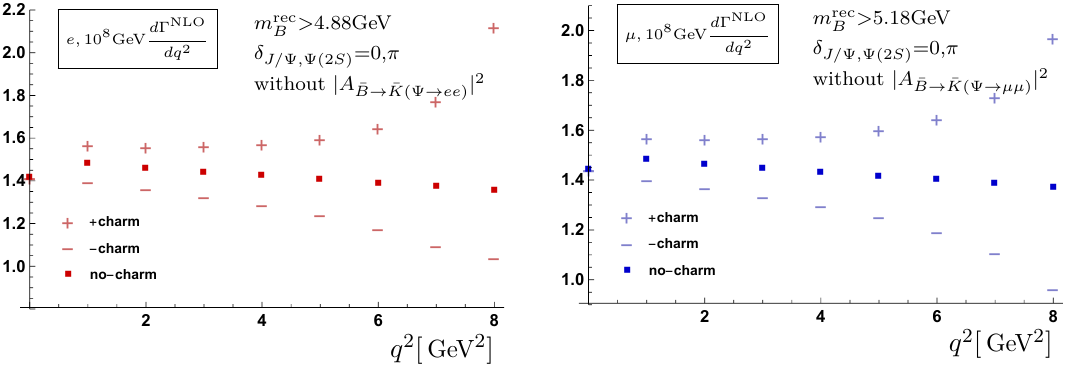
Figure 8 . Same plots as in figure 5 without LO-normalisation.